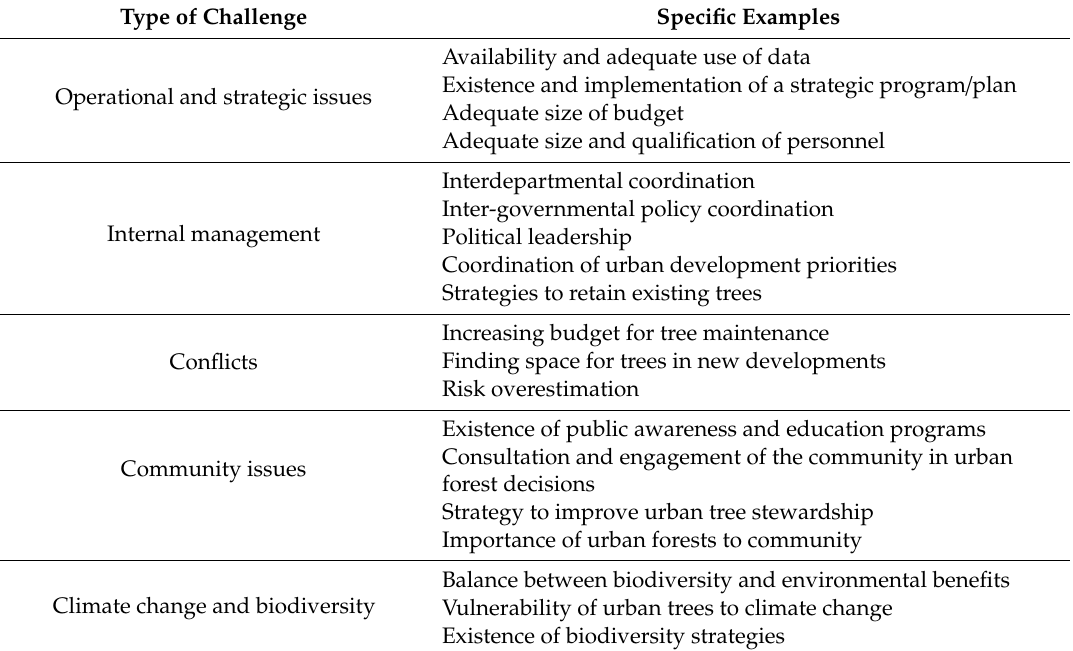
Table 1. Management and governance challenges a ff ecting the decision-making of municipal urban forest managers (based on